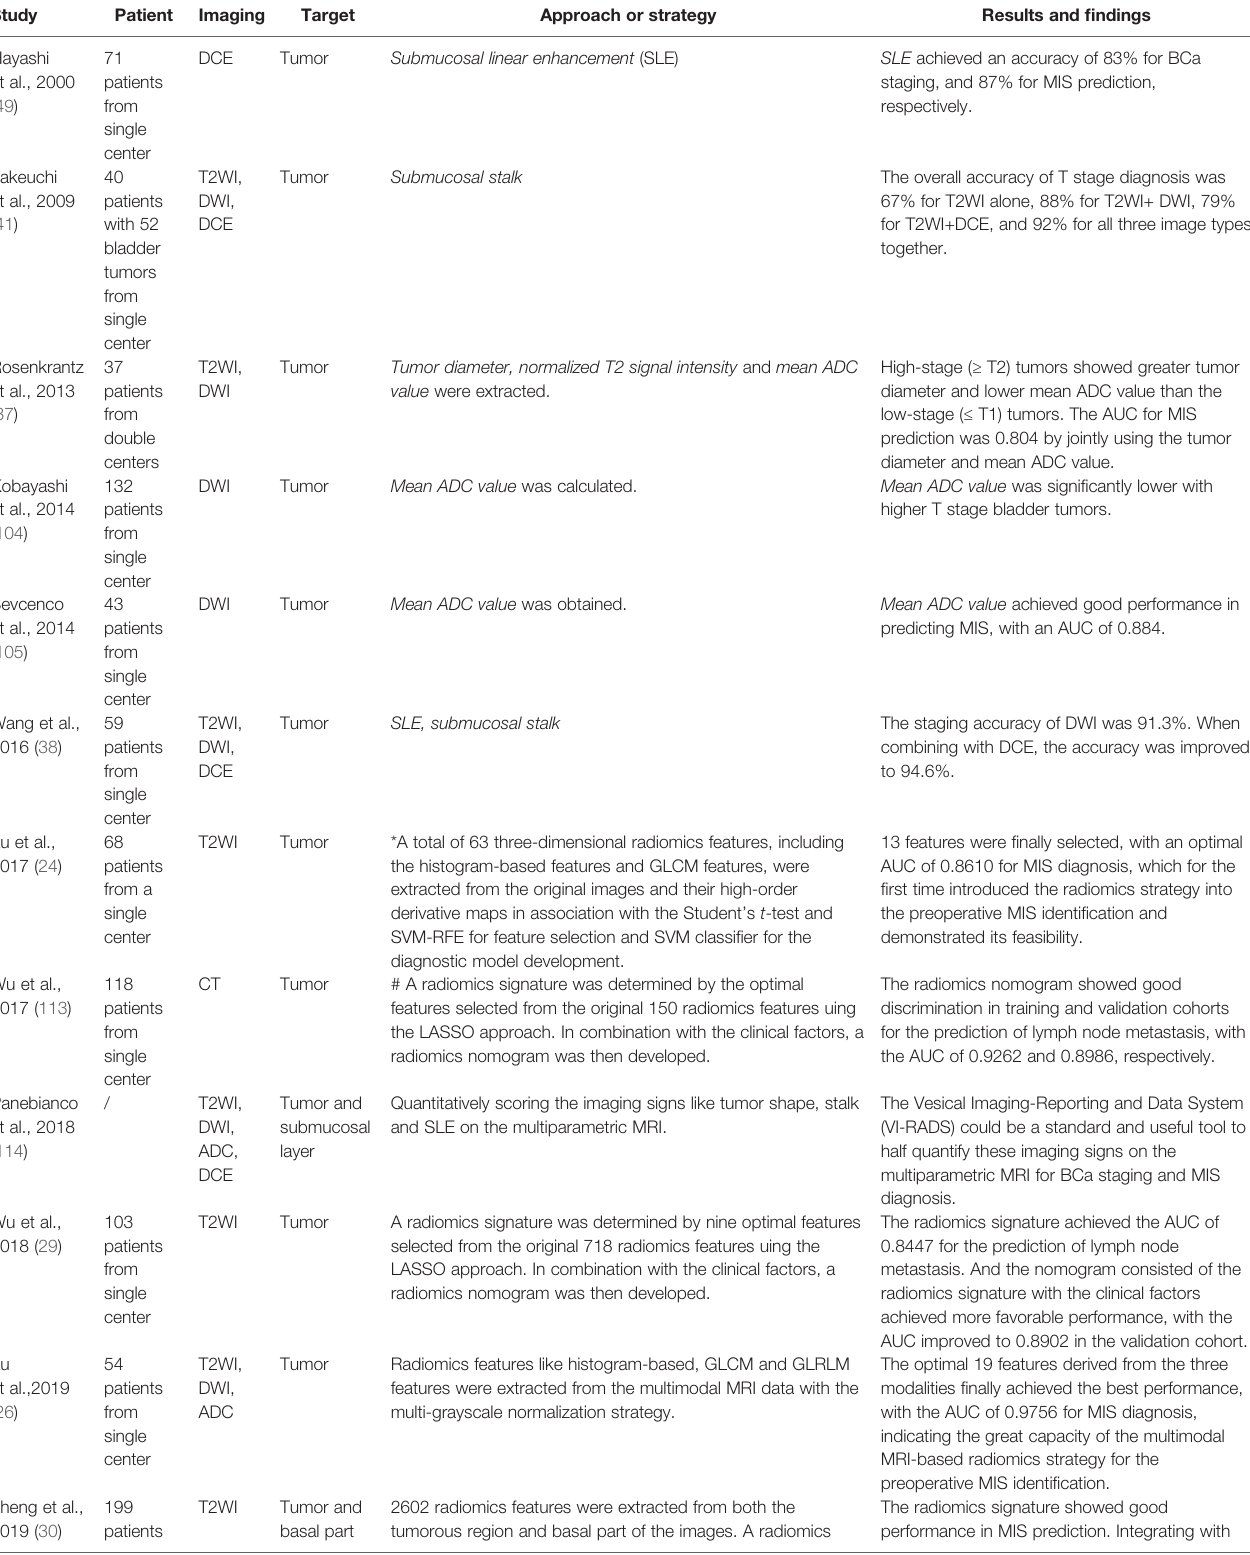
TABLE 3 | Related studies and strategies of CT-/MRI-based BCa staging and MIS prediction during the past 20 years.